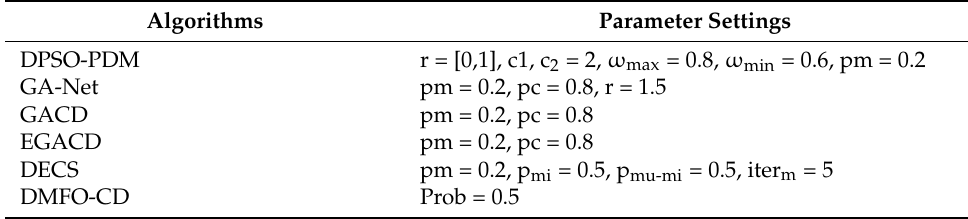
Table 1. Parameter settings.